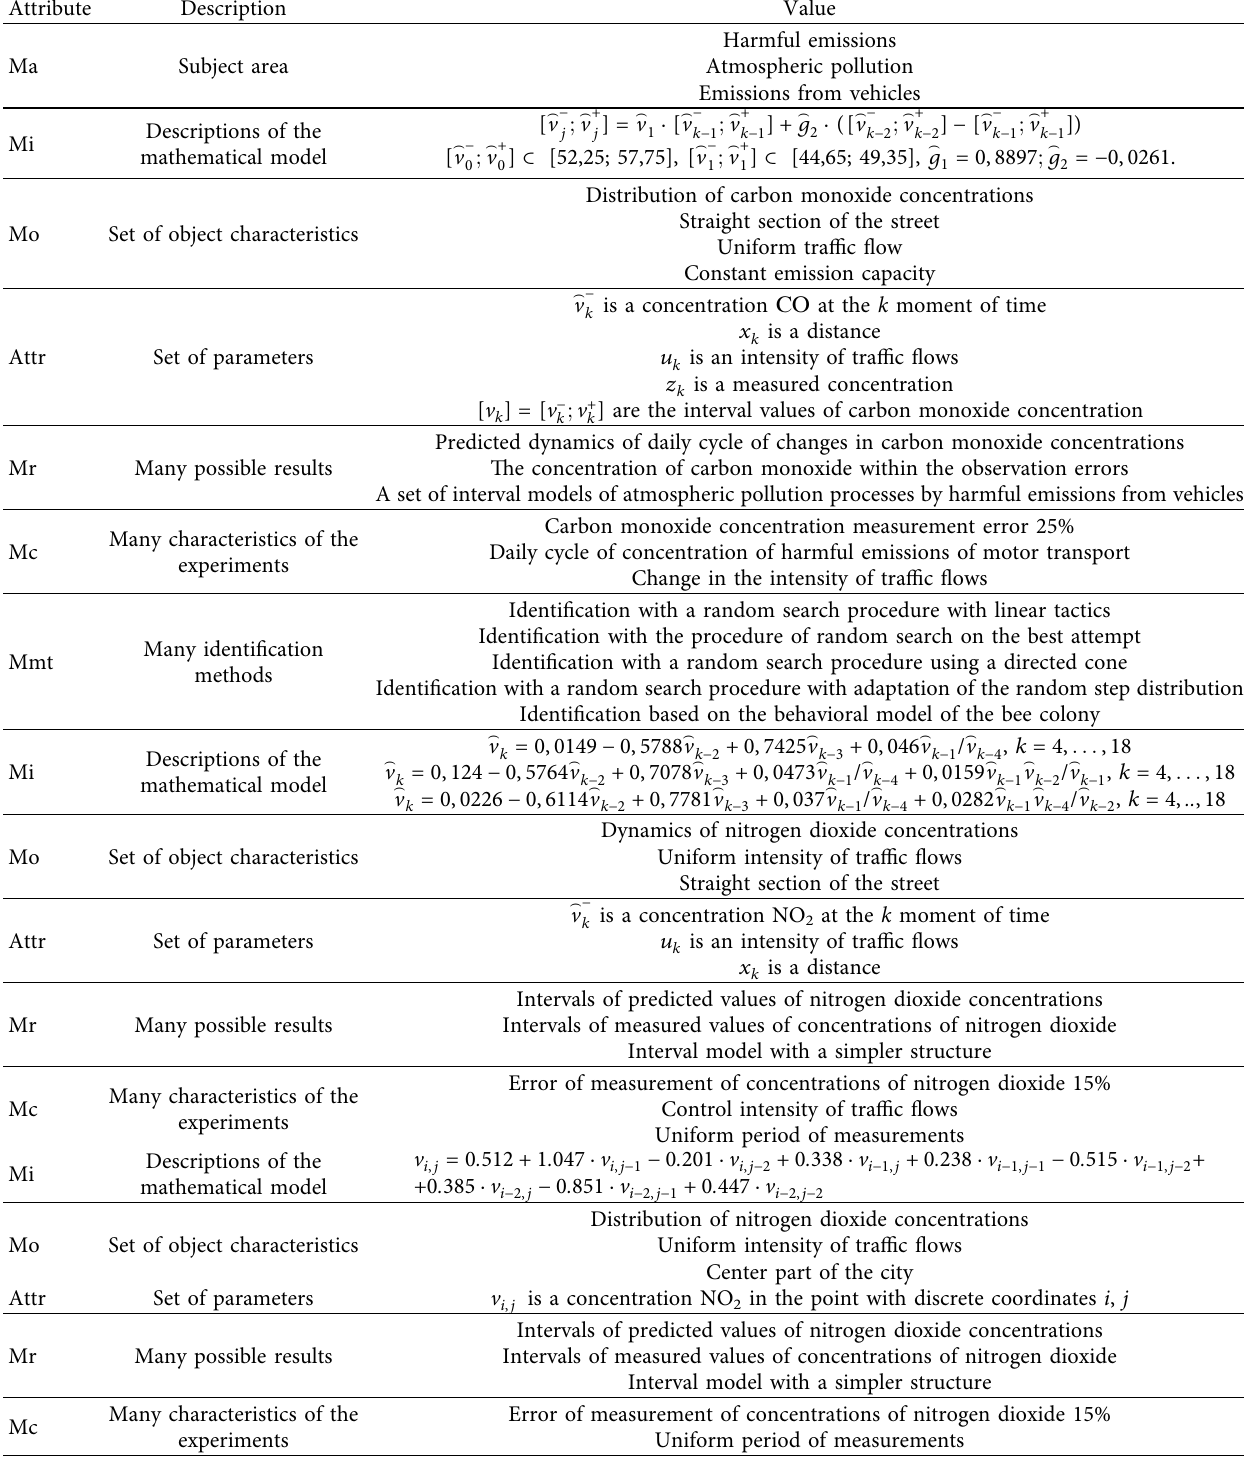
Table 2: Example of formalized representation of mathematical models based on interval data for air pollution processes by harmful emissions from